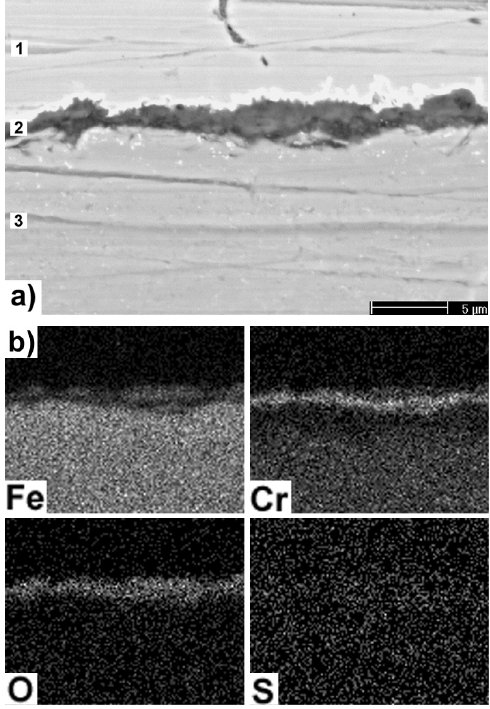
(cid:3) 15 %H 2 O (cid:3) 13 %O 2 . 2